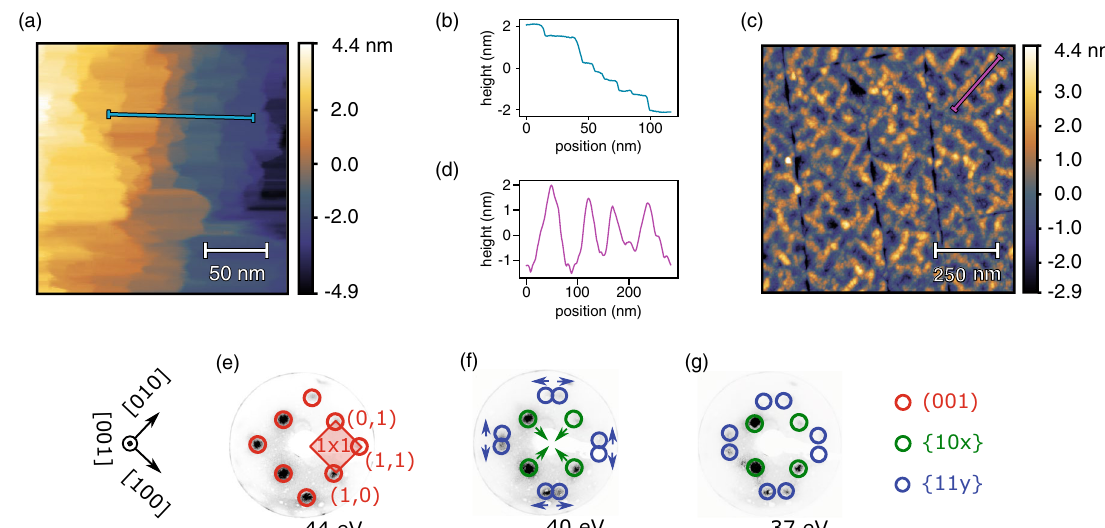
Figure 1. Surface morphology of VO 2 films grown by rMBE and MAD. ( a ) STM images reveal large (001) terraces on the rMBE films after thermal annealing. ( b ) The height profile, corresponding to the path highlighted in blue in the image, shows integer atomic steps between the terraces. ( c ) AFM images of the MAD film exhibit a ripple-like texture. ( d ) The corresponding height profile depicts a slightly inclined (stepped) (001) surface. ( e – g ) LEED patterns of the rMBE films at different energies show a rutile ( 1 11 y 10 x also feature and facet reflections ( f , g { } { }